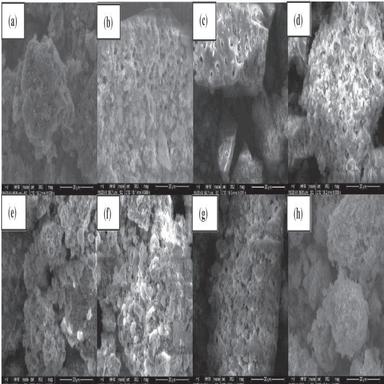
BSE/mapping images for the powdered materials: (a) TC0; (b) TC1; (c) TC2; (d) TC3; (e) TC4; (f) TC5; (fg) TC6; (h) TC7.